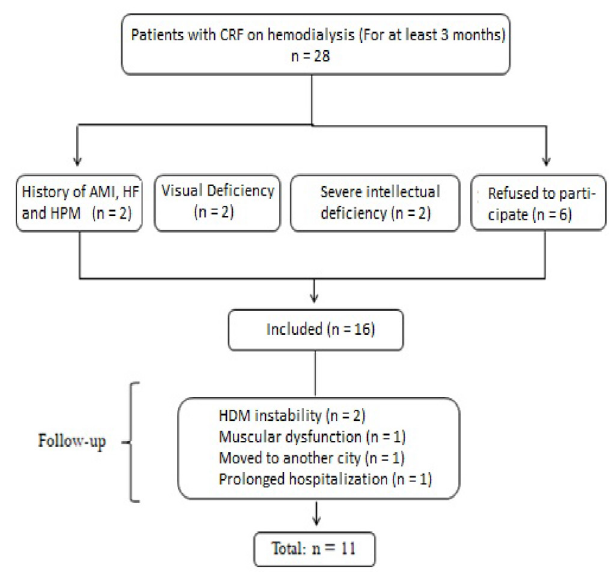
Figure 2 - Flowchart of selection of study participants; CRF: Chronic Renal Failure; AMI: Acute Myocardial Infarction; HF: Heart Failure; HPM: heart pacemaker; HDM: